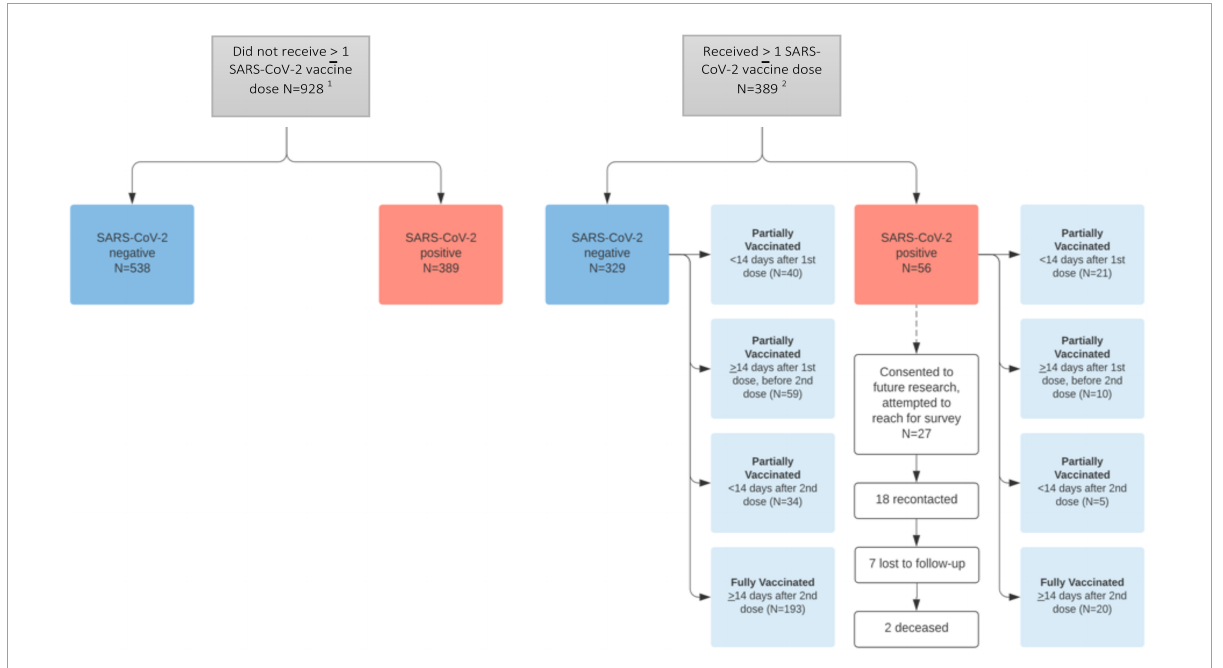
FIGURE1 Study population. 1 One undetermined result in “Did not receive > 1 SARS-CoV-2 vaccine dose.” 2 One undetermined result in “Received > 1 SARS-CoV-2 vaccine dose” and three missing vaccination dates (and thus vaccine status) in “received > 1 SARS-CoV-2 vaccine dose > SARS-CoV-2 negative.” Abbreviation: SARS-CoV-2, severe acute respiratory syndrome coronavirus